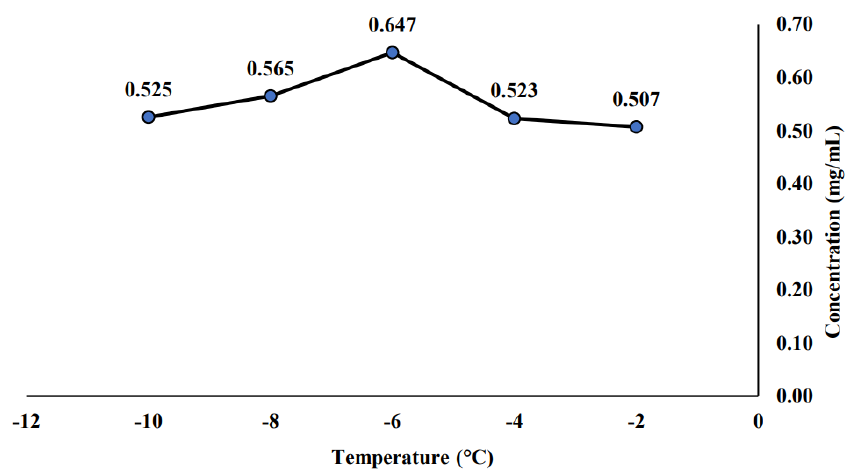
Figure 1. Saponin concentration of initial PFC sample at different temperatures.